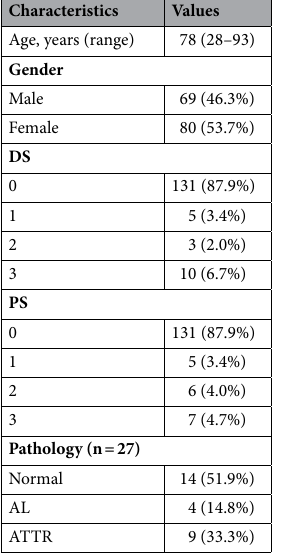
Table 1. Characteristics of enrolled patients. ATTR transthyretin amyloidosis, AL light-chain amyloidosis, DS Dorbala grading system, PS Perugini grading